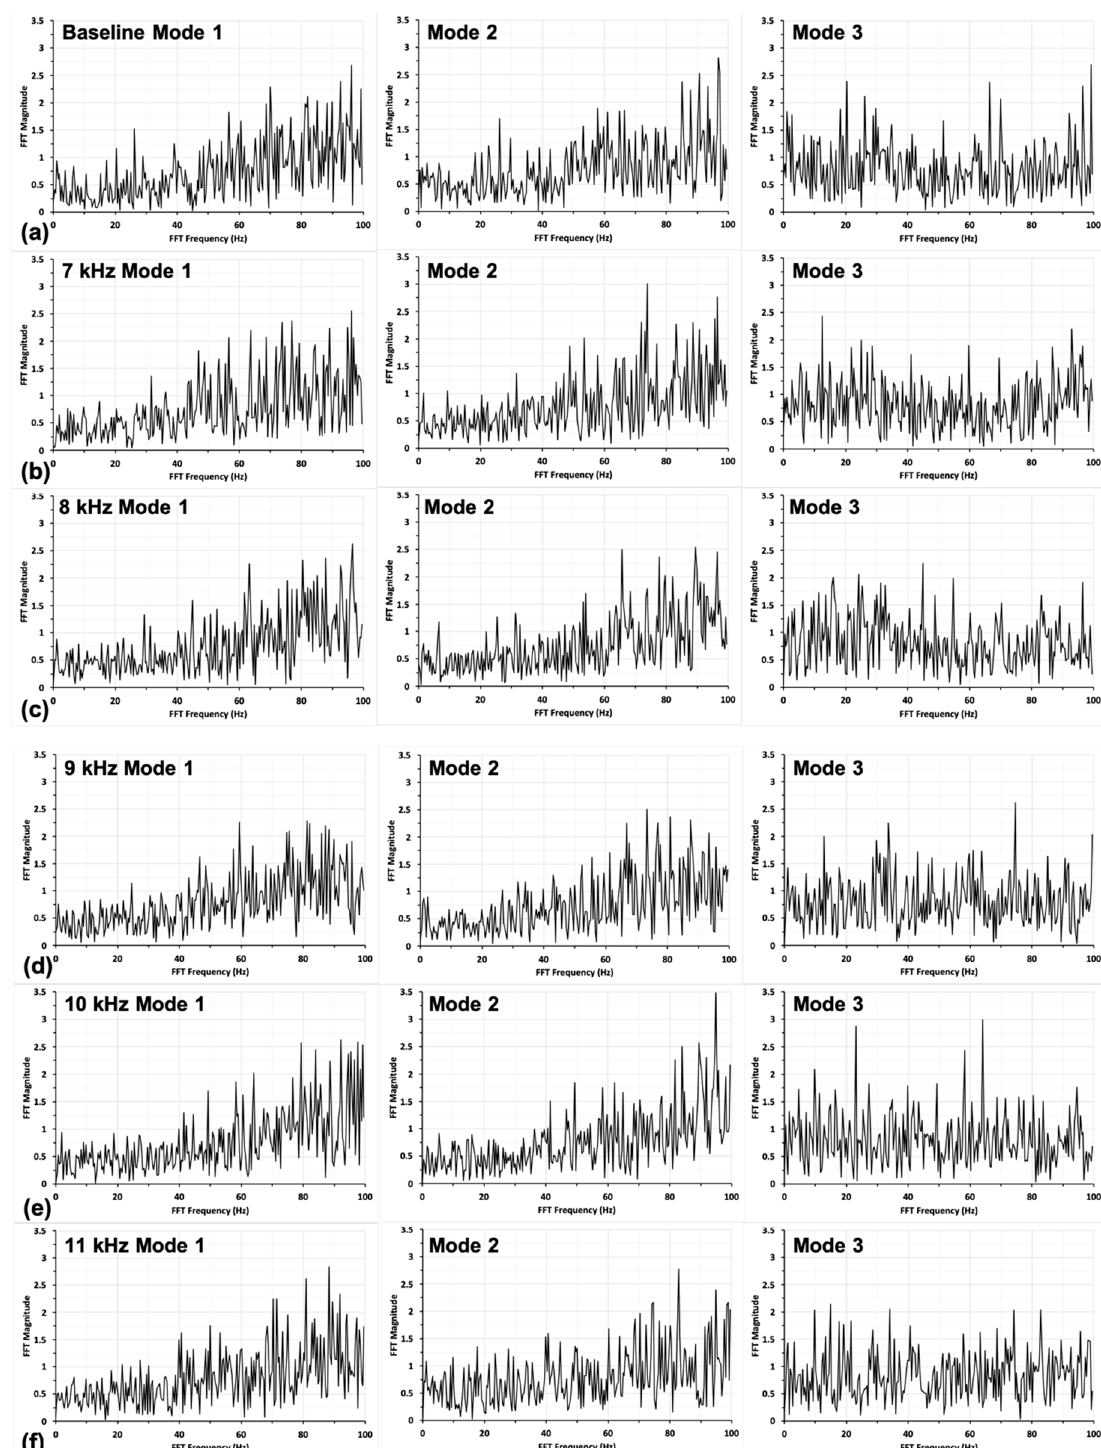
Figure 19. Frequency characteristics of the first three modes of the wake region at different AC-DBD plasma actuation frequencies. ( a ) Baseline (0 kHz), ( b ) 7 kHz, ( c ) 8 kHz, ( d ) 9 kHz, ( e ) 10 kHz, and ( f ) 11 kHz.